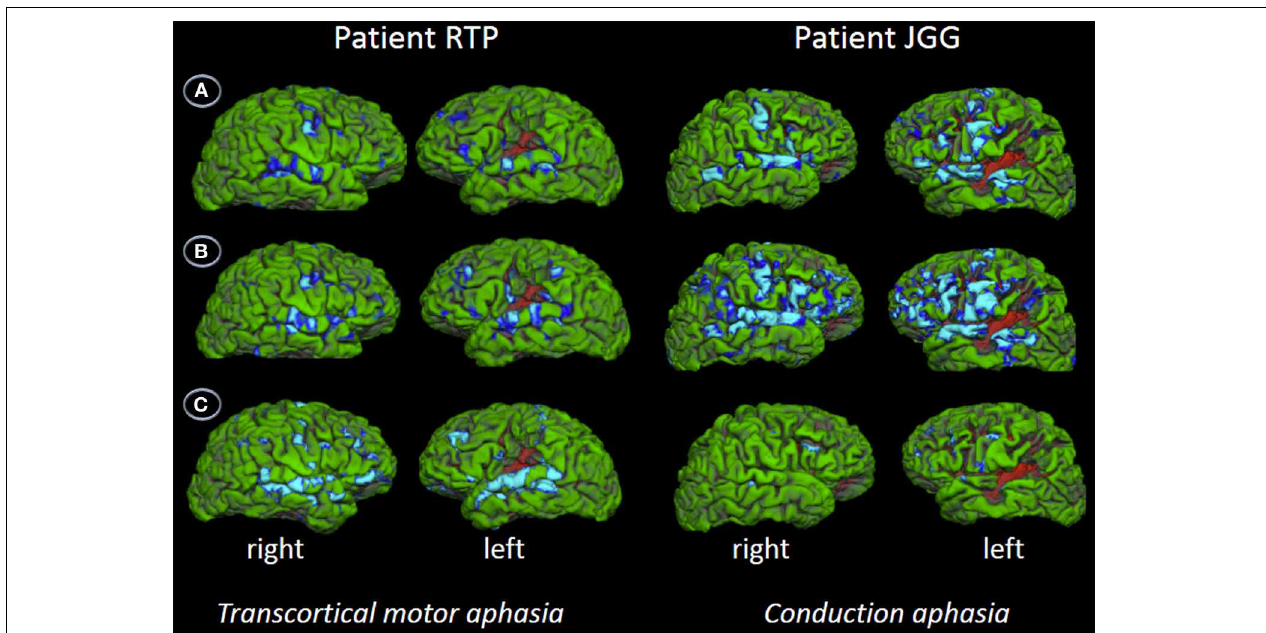
FIGURE 5 | Functional MRI. The figures show the contrast words (A) , nonwords (B) , and word triplets (C) versus rest. Contrasts are shown on patients’ uninflated cortical surface of the right and left hemispheres and significant activations ( p < 0 . 05, corrected) are depicted in light blue and blue. The fMRI shows bilateral perisylvian activation in both patients in all three